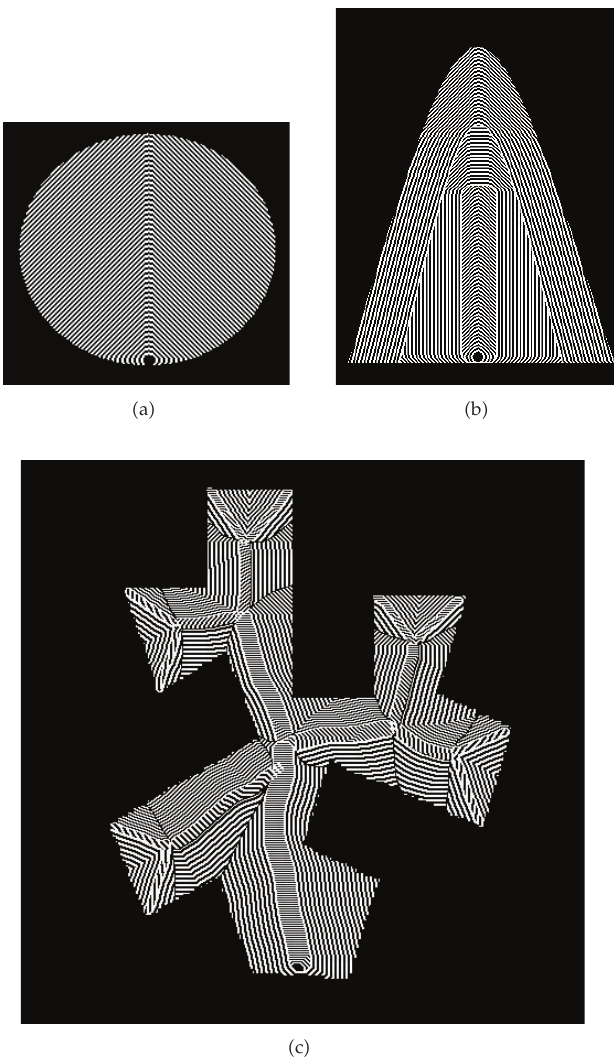
Figure 6: (cid:2) a (cid:3) Flow fields with isotropic propagation, (cid:2) b (cid:3) isotropic flow fields, and orthogonality between the flow fields of channelized and nonchannelized zones is obvious, and (cid:2) c (cid:3) flow fields within the tidal